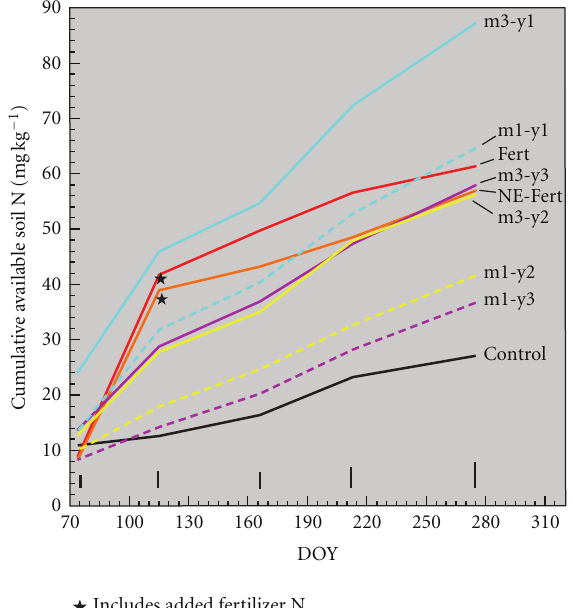
Figure 3: Cumulative net soil N available through mineralization and any fertilizer addition in the 0-to-30cm soil during the 2007 sugarbeet growing season (measured on dates (DOY) 15 Mar. (74), 25 Apr. (115), 15 June (166), 1 Aug. (213), and 2 Oct. (275). Bar length represents the mean standard error ( n = 4) for the 9 treatments at the given measurement